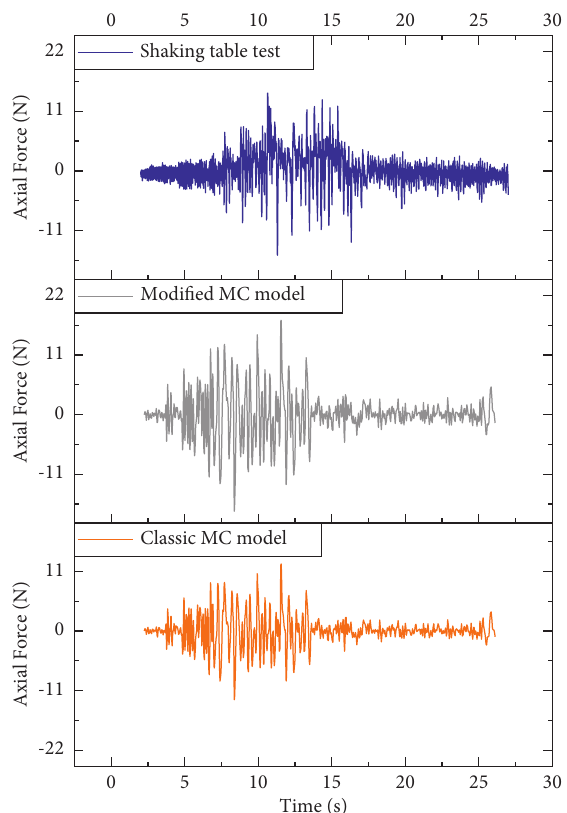
Figure 26: Axial force time history of section 1 spandrel.